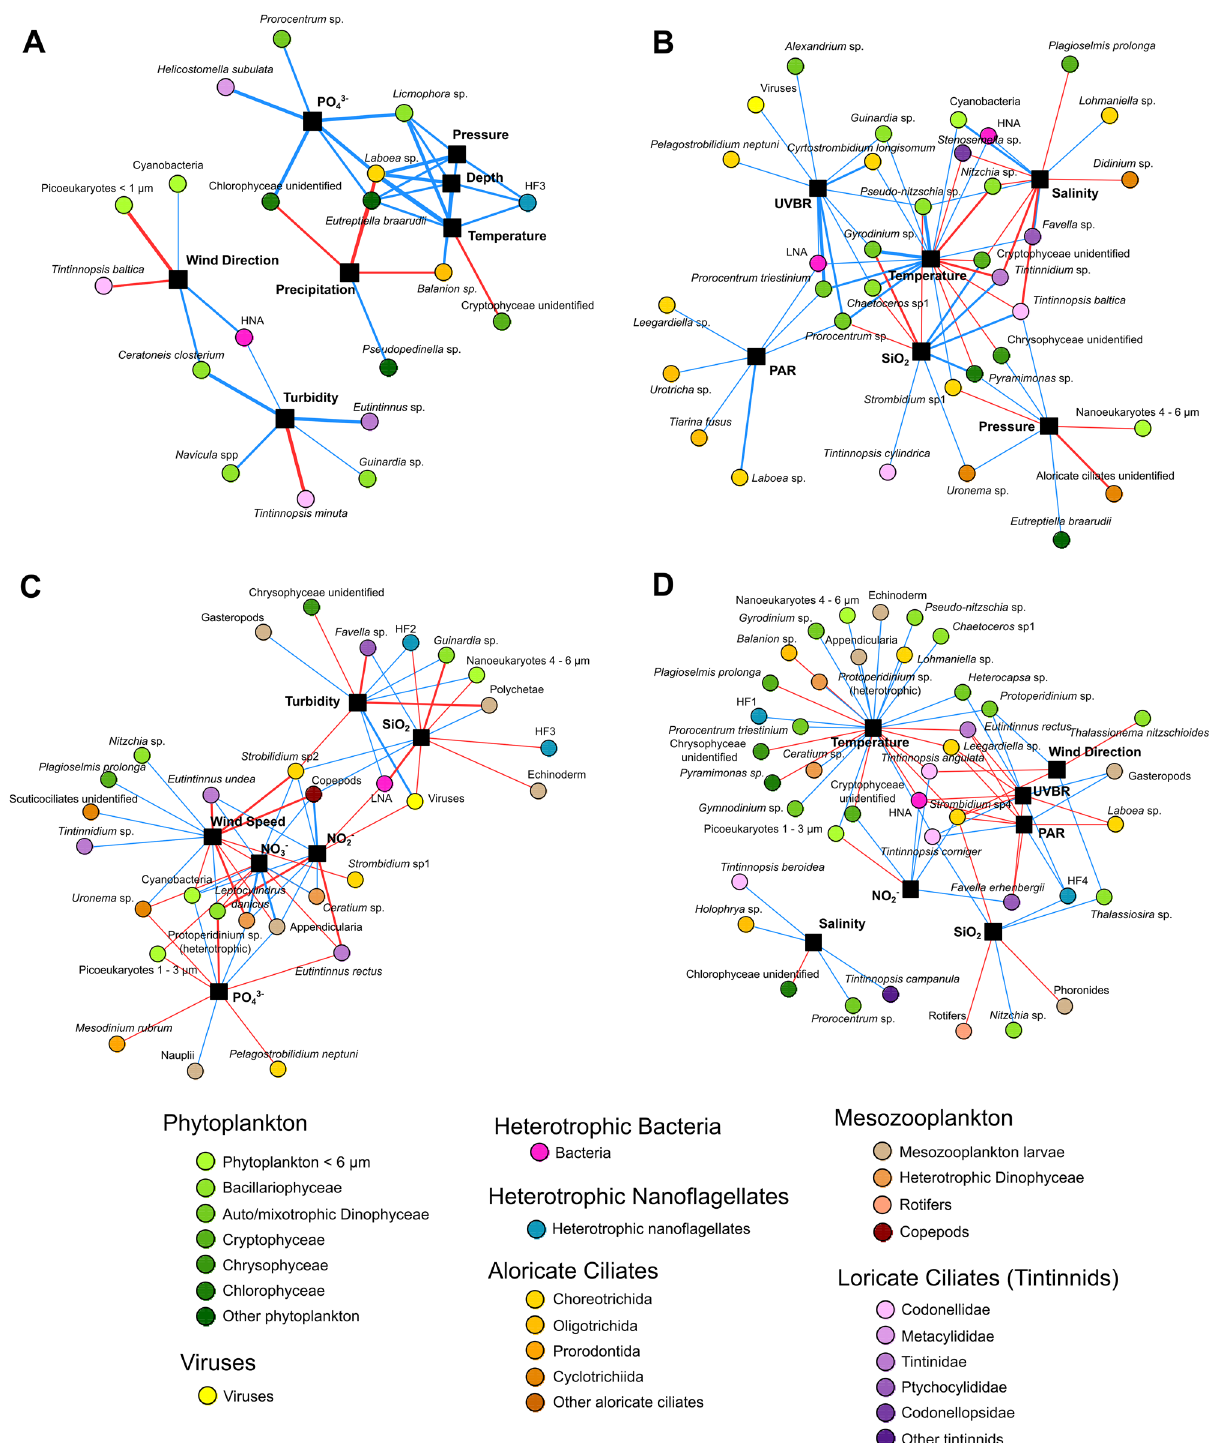
Figure 4. Networks of the environmental factors most correlated with the abundance of taxonomic groups in 2015 [non-bloom ( A ) and bloom ( B )], and in 2016 [non-bloom ( C ) and bloom ( D )]. Correlations were determined using Spearman’s rank method. Environmental factors correspond to black nodes While plankton taxa were coloured. Following taxonomic clustering. Blue and red edges represent positive and negative correlations, respectively. Correlations among plankton taxa or within the group of environmental factors are not shown for the sake of image clarity. Air temperature was not considered because it provides redundant information with water temperature. Only the most correlated environmental factors of each period were depicted while those less relevant were omitted (see Table